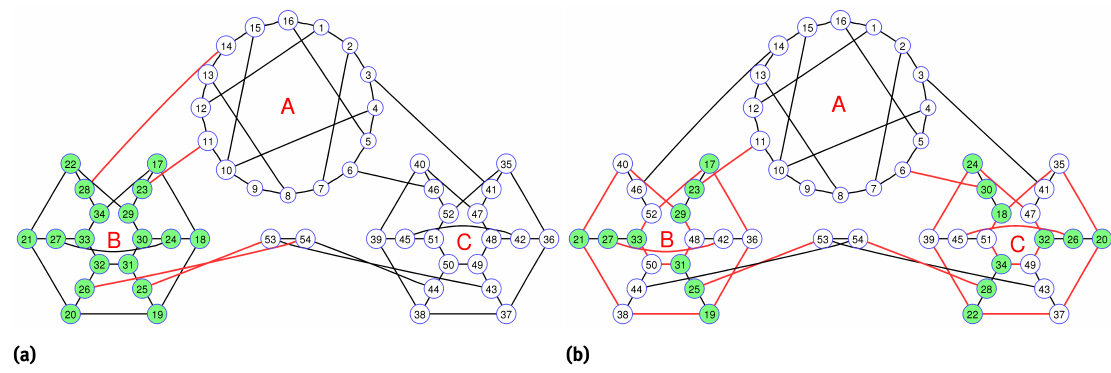
Figure 3: Ellingham-Horton 54-graph. Obvious static community structures are labelled “A”, “B”, “C”. Shown is the result of the spectral bisection method described in Section 2 using L . The resulting partition is shown as V 1 (colored vertices), V 2 (non-colored vertices) and the partition boundary (red edges). (a) G : | C ( V 1 , V 2 ) | = 4 , D ( V 1 ) = 54 , D ( V 2 ) = 108 . (b) π ( G ) : | C π ( V 1 , V 2 ) | = 30 , D π ( V 1 ) = 54 , D π ( V 2 ) = 108